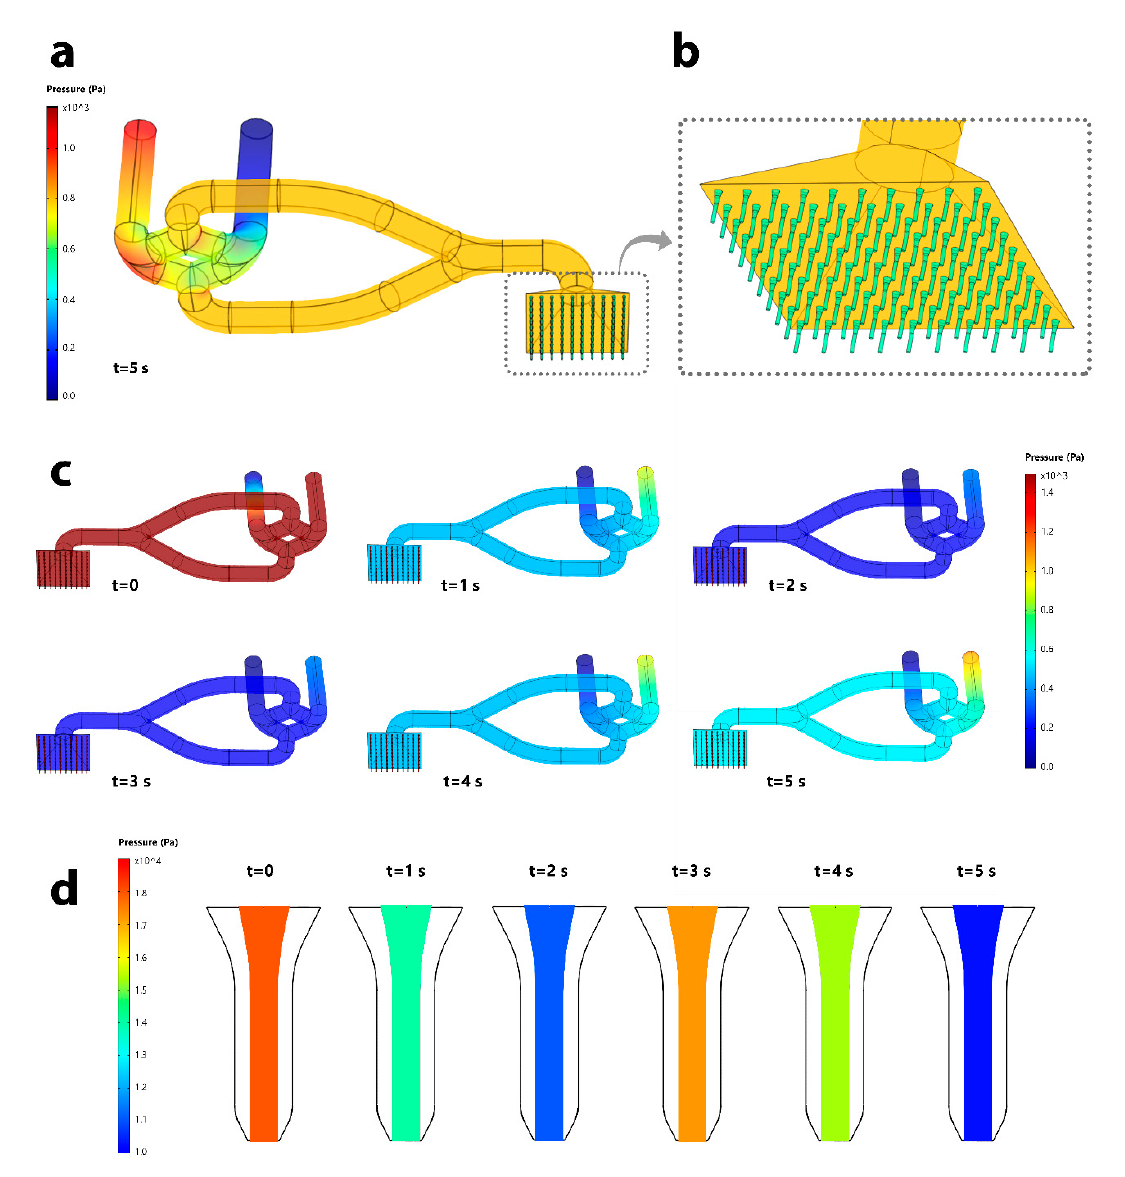
Figure 3. Pressure distribution results. ( a ) For interstitial fluid (ISF) and pressing the mechanical pressure input button every 5 s (study case 5 in Table 3), the pressure distribution in the fifth second is represented here along with ( b ), the magnified view of the microneedle array (MNA) area. ( c ) Pressure distribution in the device for human blood with input function of the heartbeat imitation and pressing the mechanical pressure input button every 5 s (study case 3 in Table 3), and ( d ) the magnified view of one microneedle (MN). All color bars show the amount of pressure in Pascals (Pa).